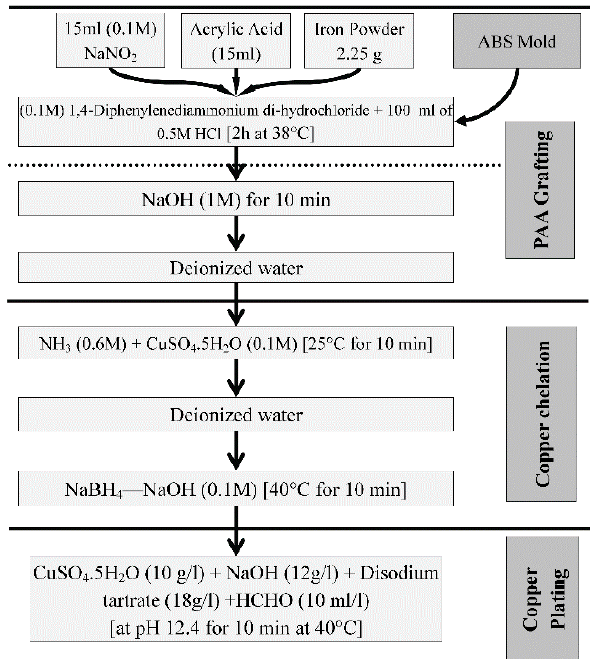
Figure 3. Copper plating on ABS through grafting process.